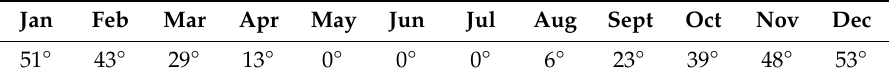
Table 1. Monthly tilt angles for optimal performance at Majmaah. Adopted from [44] (License Number: 486659005457).